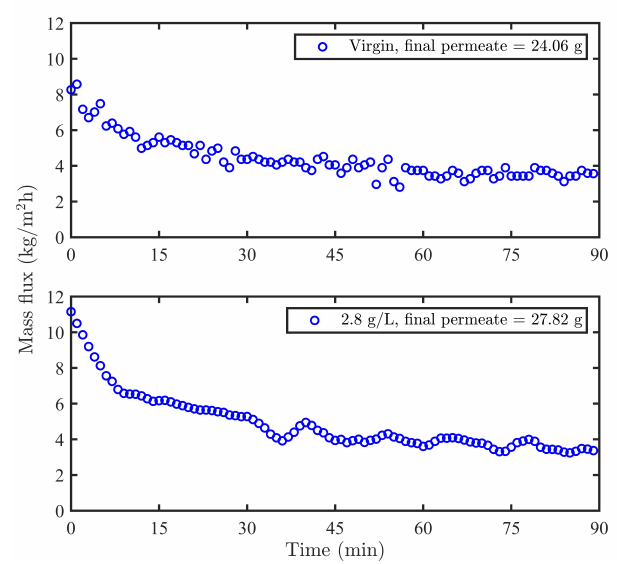
Figure 7. The effect of modification on the wood extract permeance. Table 6. TOC (total organic carbon) rejection, lignin rejection, final collected permeate mass, and RSPF (relative steady permeate flux) of virgin membrane and modified one with 2.8 g/L vanillin (the average of three replicate tests).